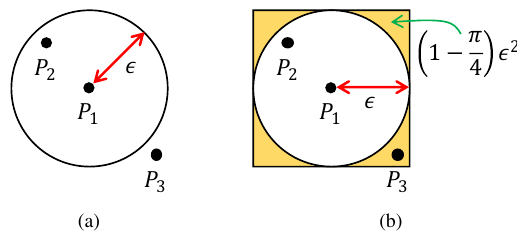
Figure 4. An illustration of a point’s neighbourhood in 2D confined by an error tolerance (cid:15) based on the Euclidean distances (left) and individual point coordinates